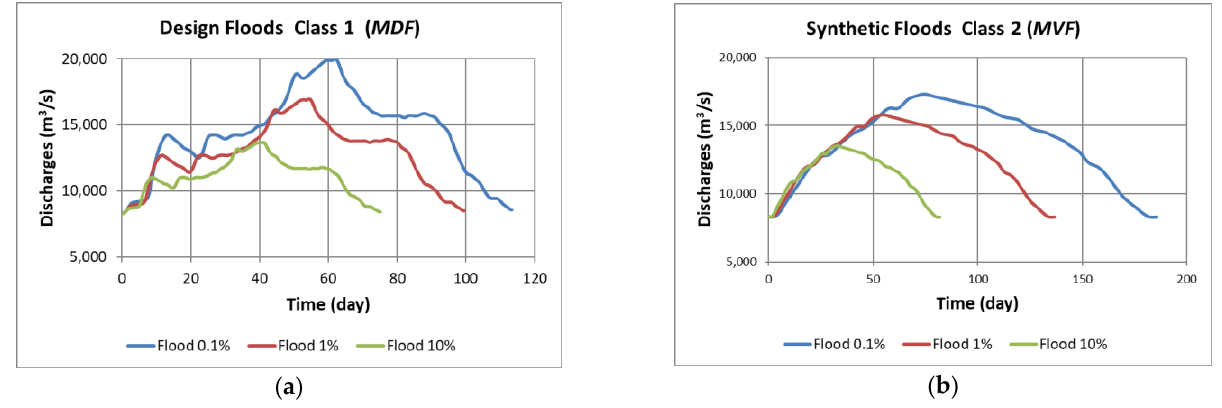
Figure 8. Design Floods: ( a ) MDF for Class 1 and ( b ) MVF for Class 2. Table 5. Main parameters of MDF Class 1 at Turnu- Măgurele gauge station.